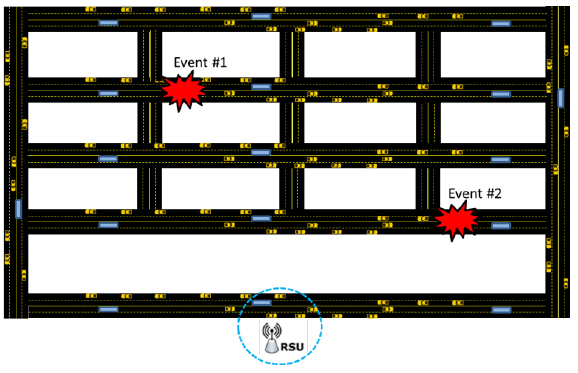
Figure 4. Manhattan-Grid Scenario.